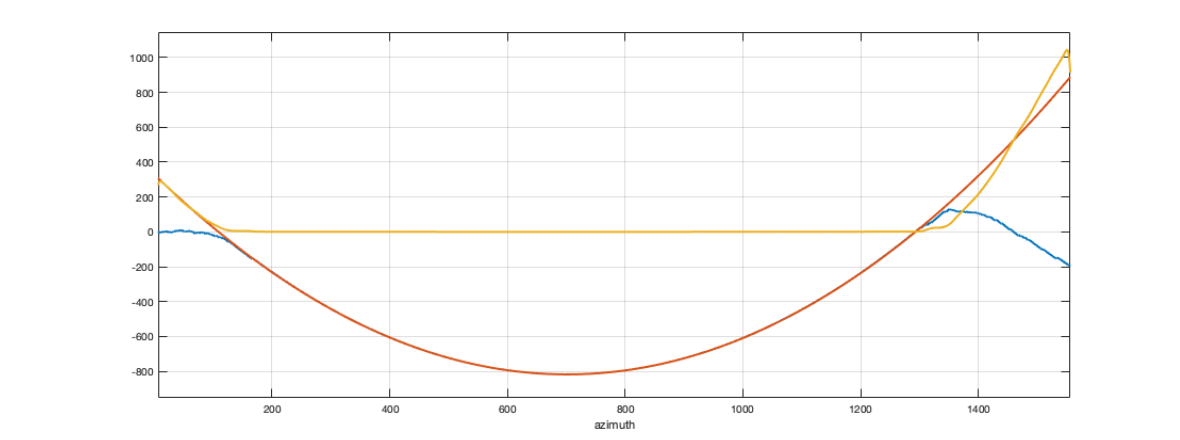
Figure 4. Phase as extracted from the first left singular vector (blue), the phase polynomial LMS approximation (red) and the phase error